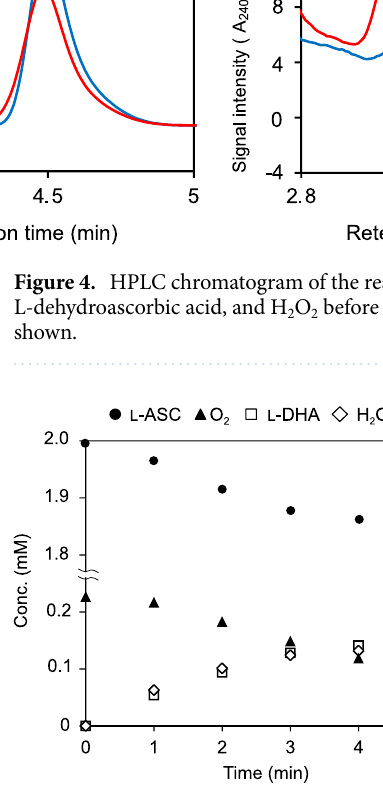
Figure 5. Stoichiometric analysis of granaticin catalysis. Time course of the concentration of L-ascorbic acid (L-ASC), O 2 , L-dehydroascorbic acid (L-DHA), and H 2 O 2 in the oxidation reaction catalyzed by